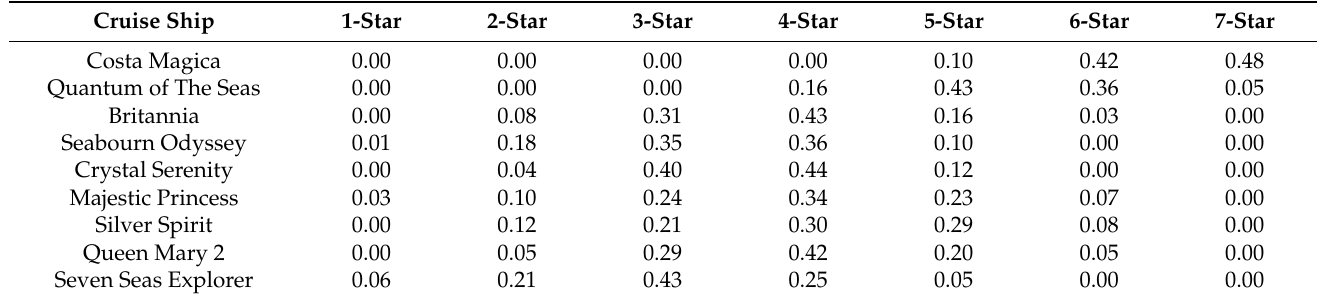
Table 11. Aggregated cruise star rating results from 15